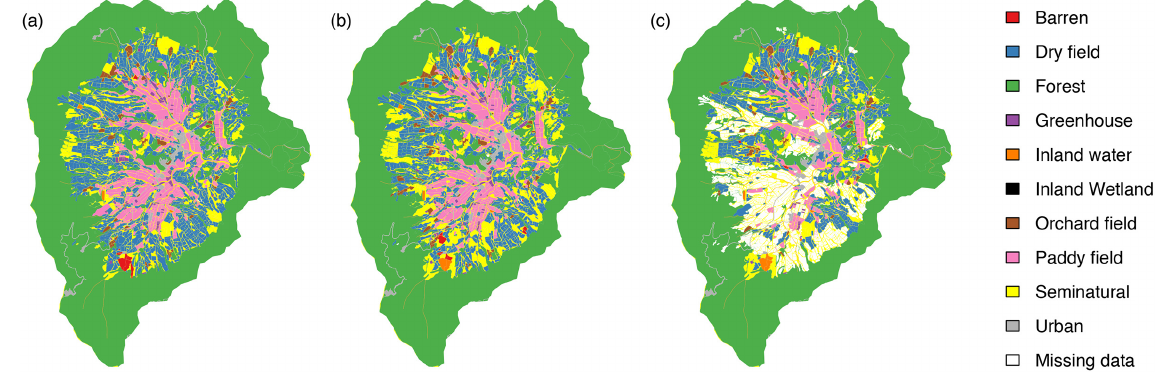
Figure 5. Land use and land cover in the Haean catchment in (a) 2009, (b) 2010 and (c) 2011 according to the classification scheme